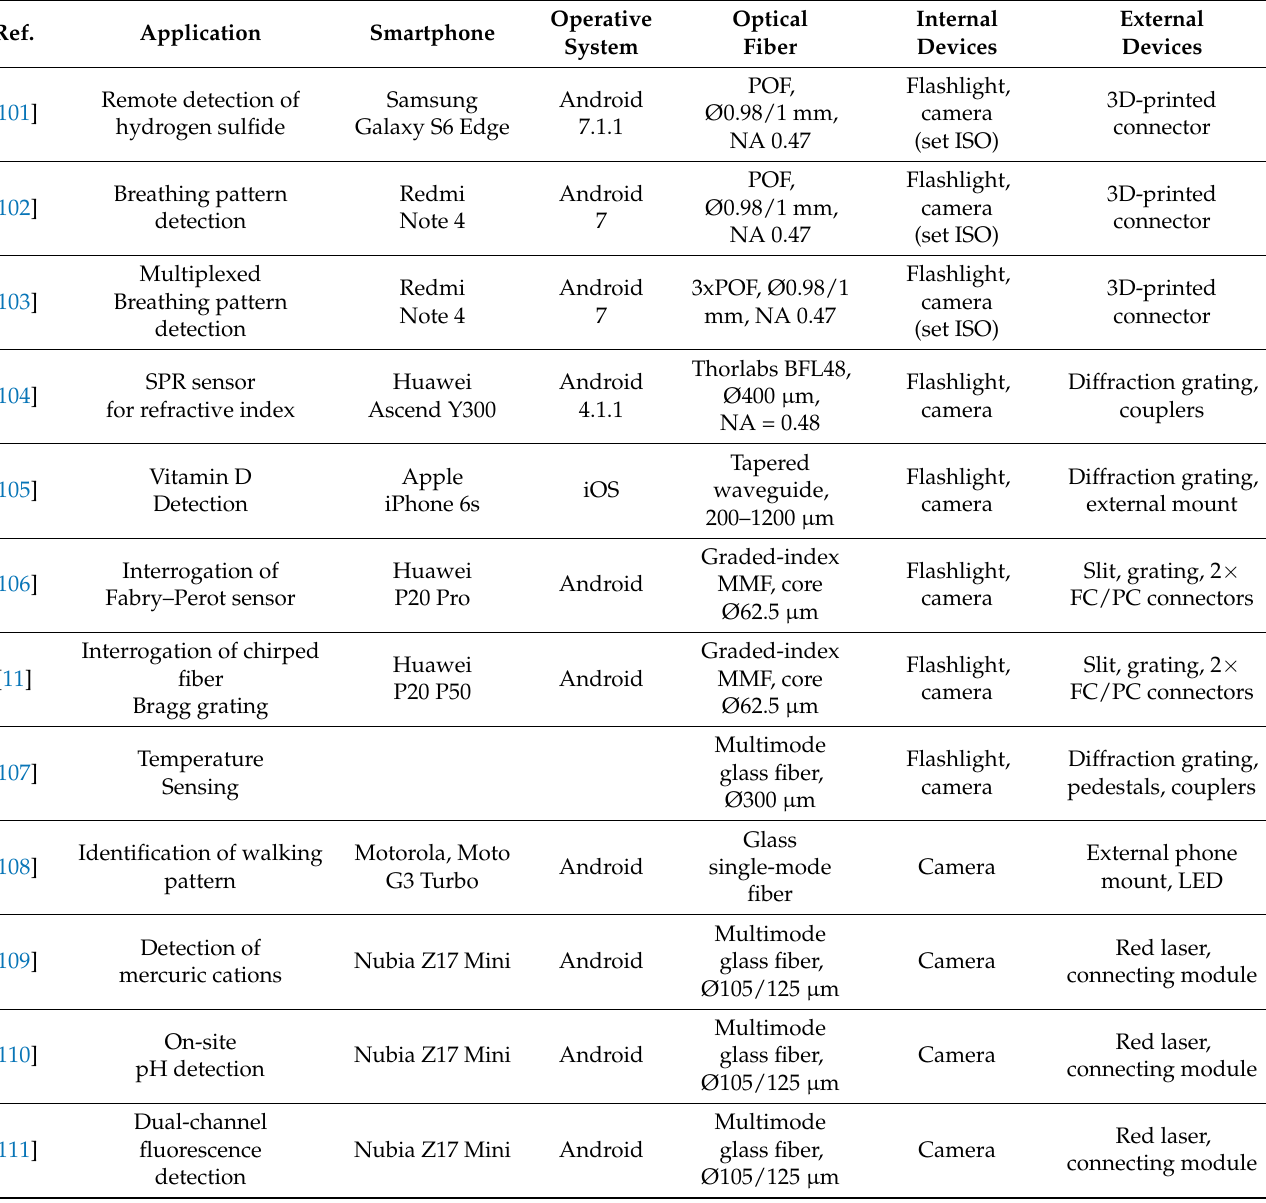
Table 1. Review of the fiber optic smartphone sensors and their applications.